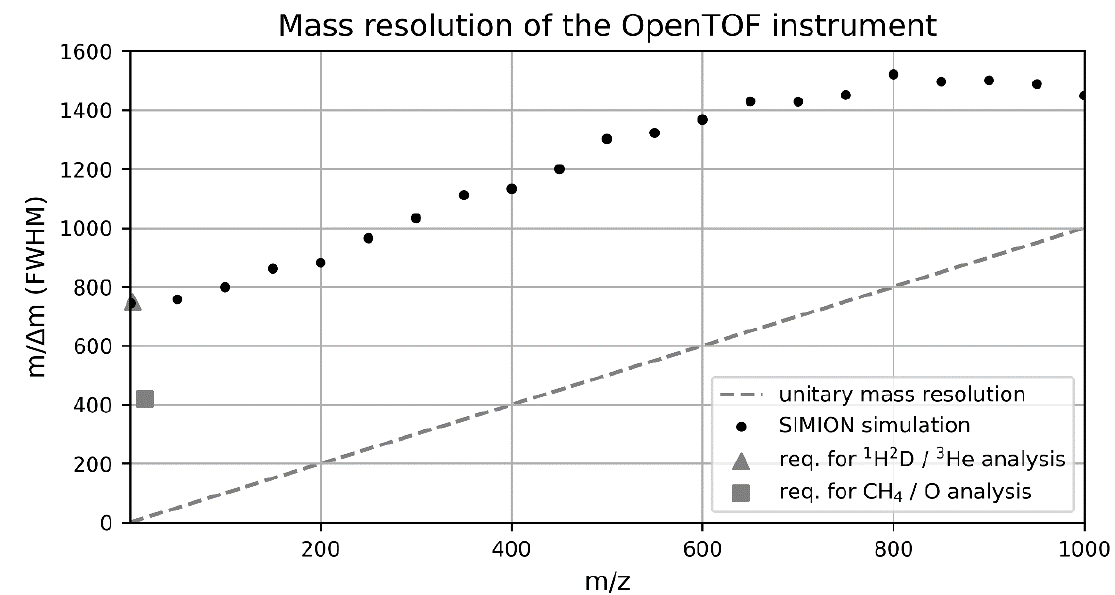
Figure 3. The mass resolution of this instrument is comparable to NIM’s mass resolution for higher masses, and even better for lower masses (see text for references). This performance is sufficient for resolving, e.g., 1 H 2 D/ 3 He and CH 4 /O, and thus answering related scientific questions.